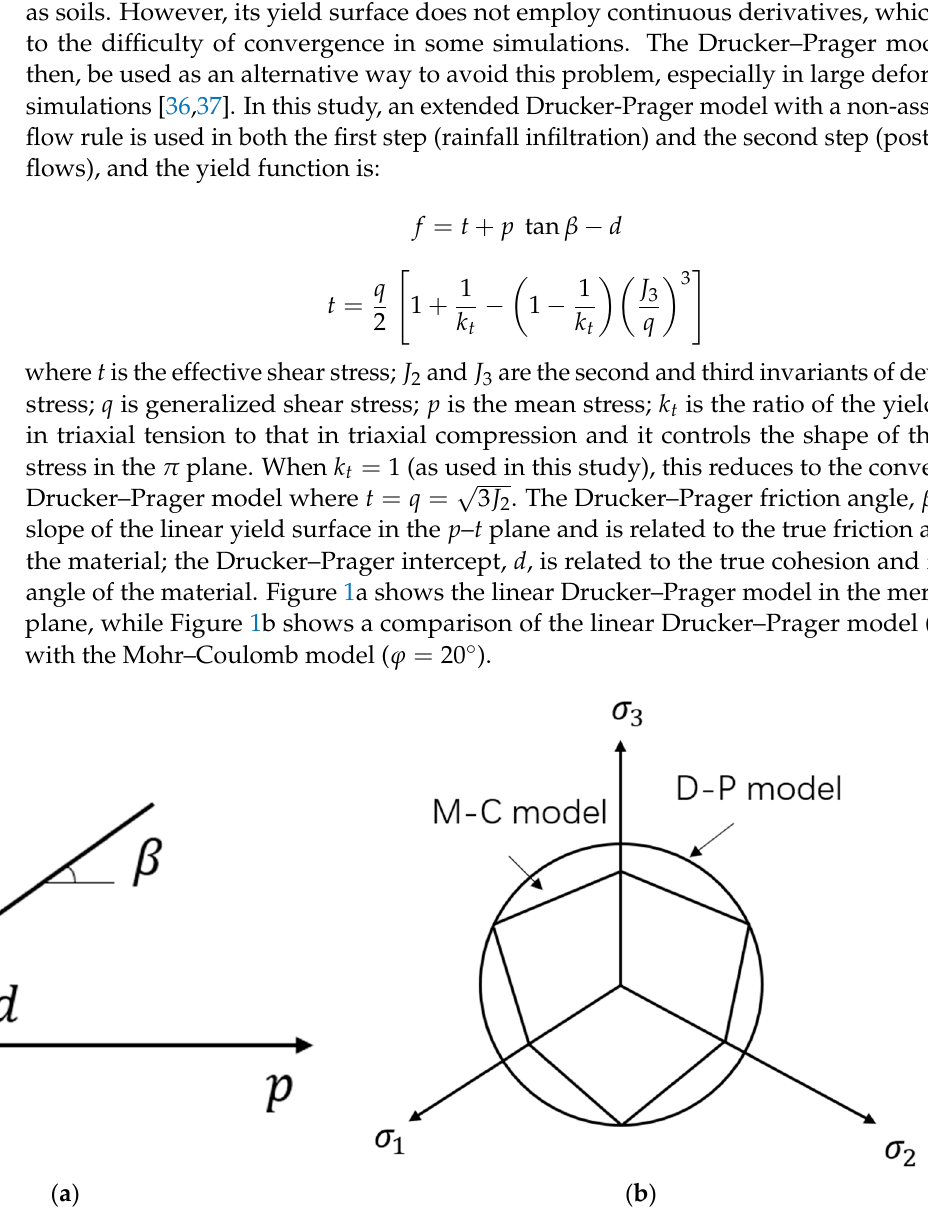
Figure 1. The illustration of linear Drucker–Prager model: ( a ) linear Drucker-Prager model on the meridional plane; ( b ) comparison of linear Drucker–Prager model ( 𝑘 = 1 ) and the Mohr–Coulomb model ( 𝜑 = 20° ).